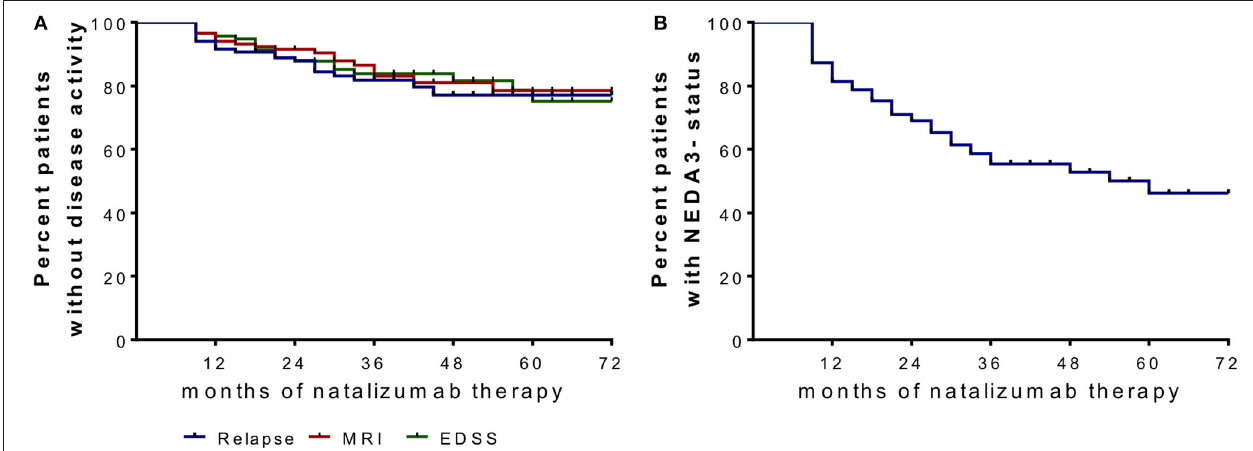
FIGURE 2 | Proportion of patients without disease activity and NEDA-3 status after NAT start. (A) Clinical parameters are depicted in a Kaplan–Meier survival curve analysis for relapses, confirmed EDSS progression ( ≥ 1.0 point increase if EDSS baseline score was < 4.0; ≥ 0.5 point increase if EDSS baseline score was ≥ 4.0) and MRI progression (one or more new T2 or gadolinium enhancing lesions) after month 6 and during 72 months follow up. (B) No evidence of disease activity (NEDA)-3 status was confirmed when criteria of no relapses, no EDSS progression and no MRI progression were met.